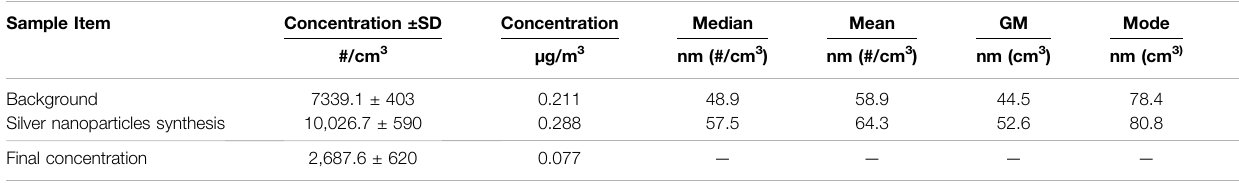
TABLE 6 | Silver nanoparticles emission data averaged over an hour (n = 3).